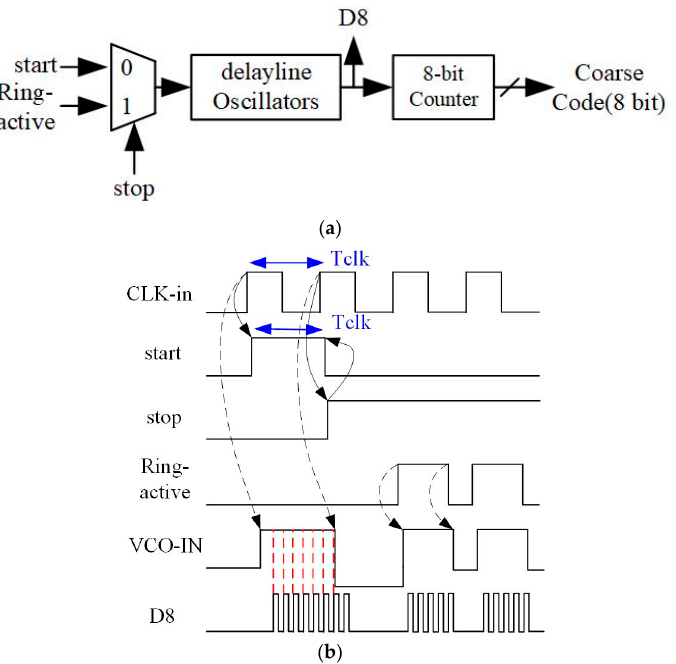
Figure 5. ( a ) The block diagram and ( b ) the timing diagram of the Coarse TDC. (VCO: Voltage- controlled oscillator)